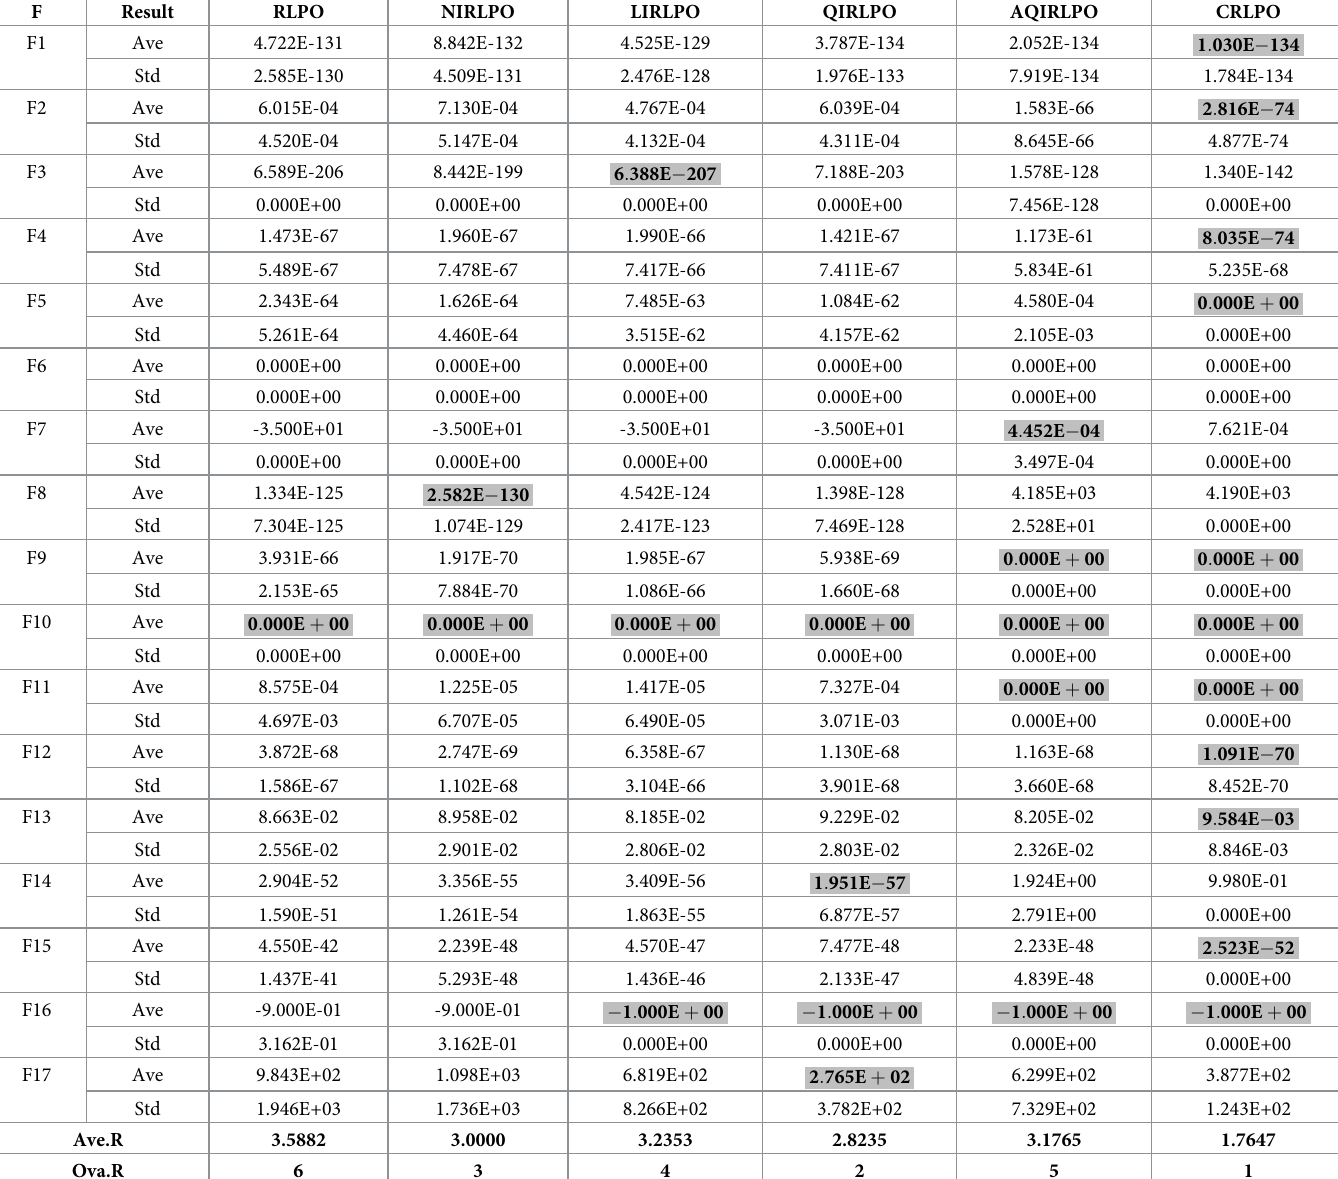
Table 13. Experimental results of RLPO with various interpolation strategies on 17 test functions from [51] (Dim = 10). F